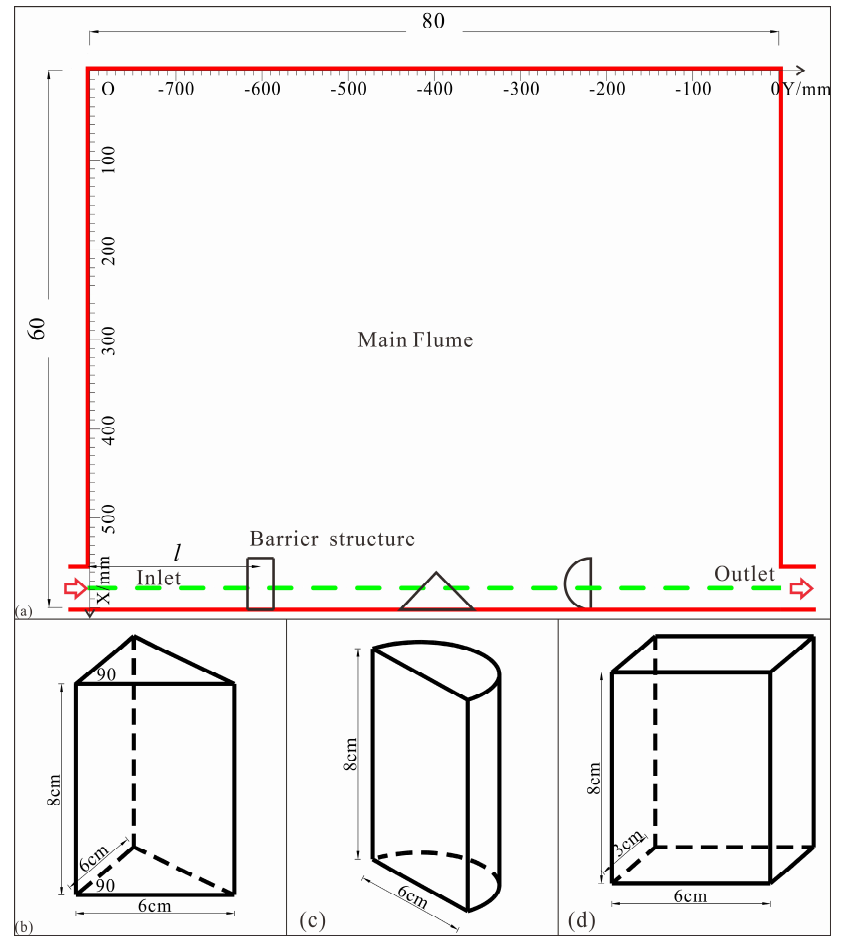
Figure 3. Schematic diagram of barrier structures in water body: ( a ) structure location; ( b ) triangular prism; ( c ) semi-cylinder; ( d ) rectangular column.